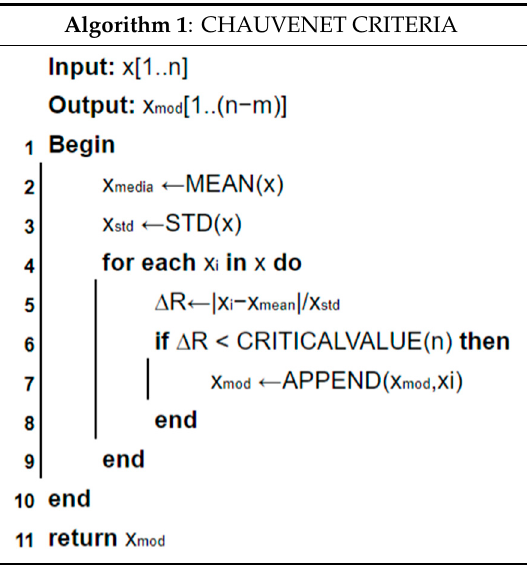
Algorithm 1. Error table that can be identified in the Data Acquisition Algorithm 1 : CHAUVENET CRITERIA